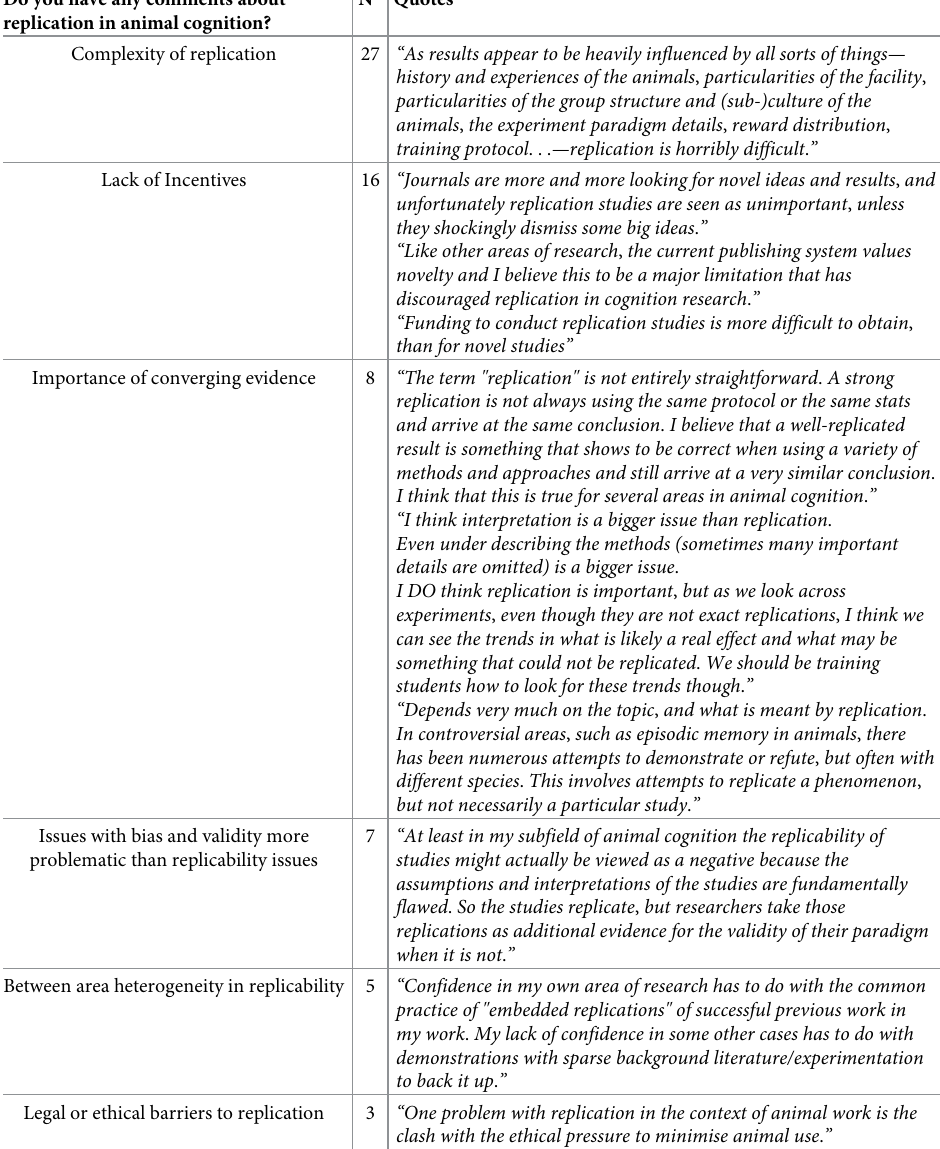
Table 7. Animal cognition researchers’ beliefs about replication in animal cognition